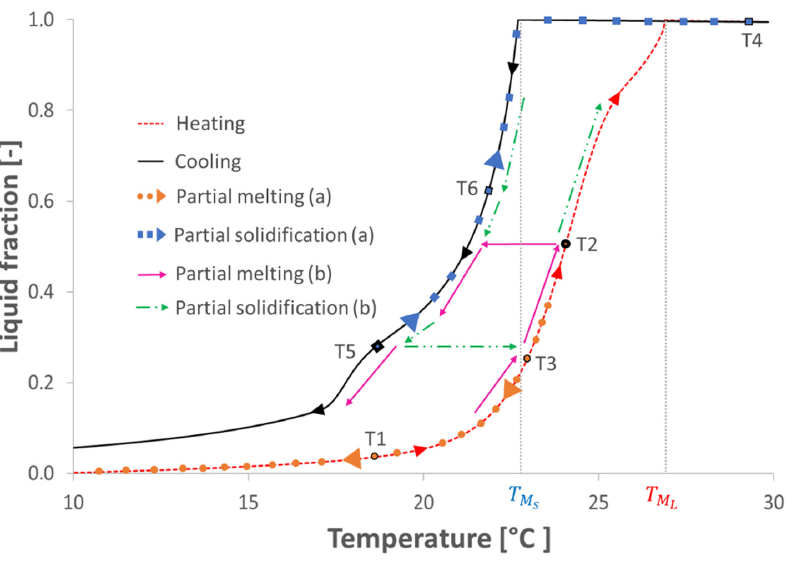
Figure 17. Evolution of the liquid fraction during partial melting/solidification, as used in our